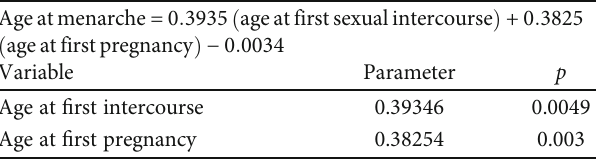
Table 3: Linear regression model between age at menarche and age at fi rst pregnancy among adolescents attended at a Basic Health